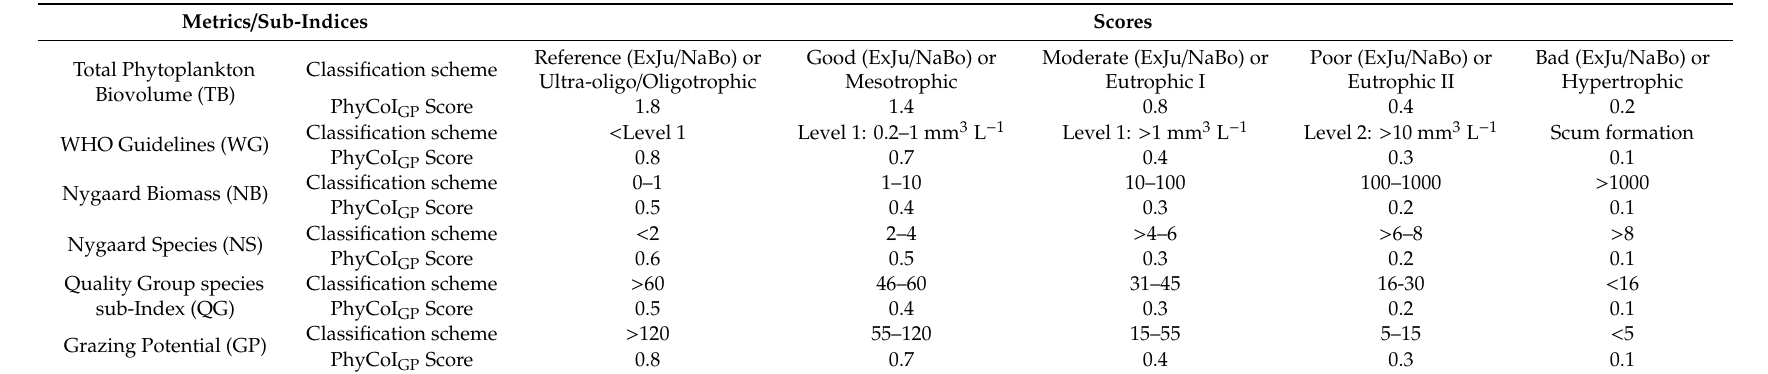
Table 2. Included in the phytoplankton community (PhyCoI GP ), their classification scheme and respective scores for its calculation (ExJu = Expert Judgment Boundaries, NaBo = National Boundaries); Boundaries for trophic state of Greek lakes according to Katsiapi et al. [37] and trophic state classification as suggested by Smith